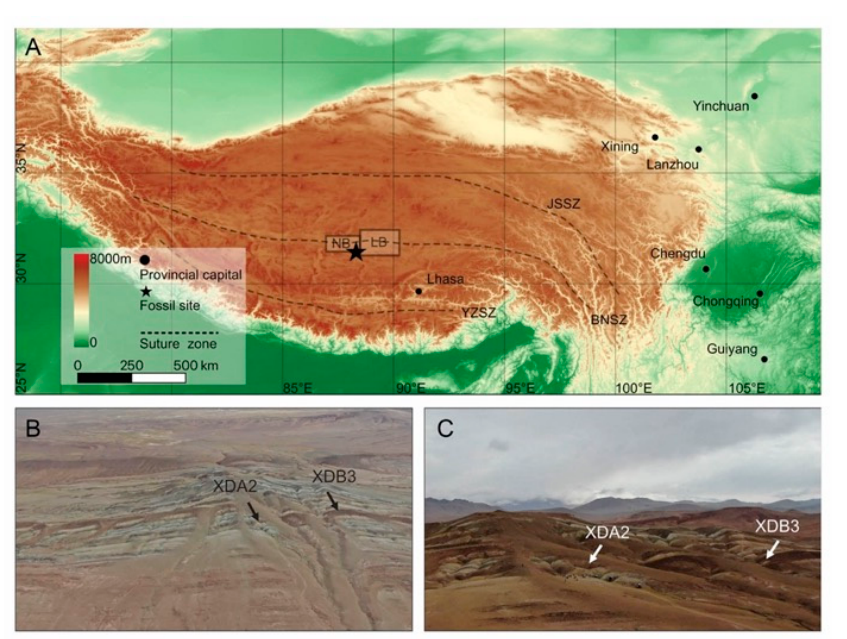
Figure 1. Maps showing the location of the fossil specimens in this study. ( A ) Localities of the Nima Basin and the adjacent Lunpola Basin in the central Tibetan Plateau. BNSZ, Bangong–Nujiang suture zone; JSSZ, Jinshajiang suture zone; LB, Lunpola Basin; NB, Nima Basin; YZSZ, Yalu–Zangbo suture zone. Map data provided by SRTM data V4 [18]. ( B , C ) The specimens were collected from fossil-bearing layers XDA2 and XDB3 in the Nima Basin, which are deposited in the same